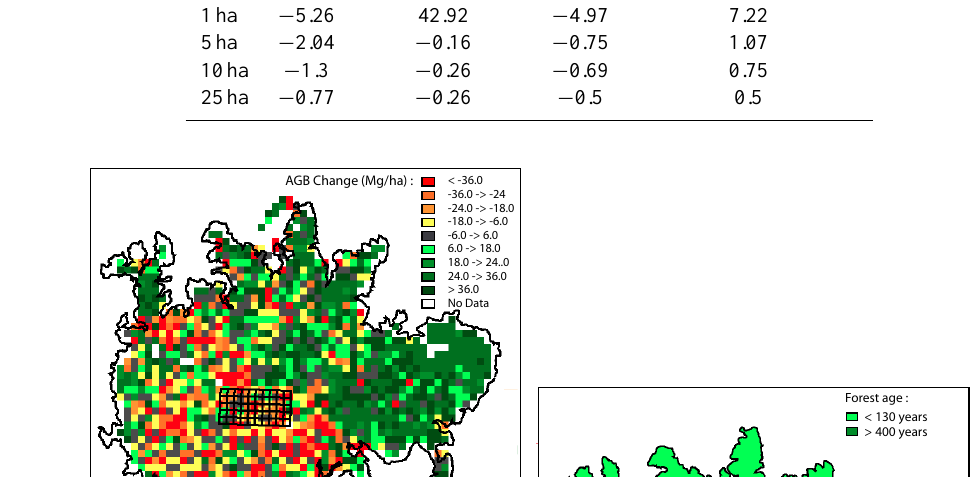
Table 5. lidar-detected AGB change (in Mgha − 1 yr − 1 ) and the difference between lidar and field AGB change estimates in the 50ha plot, at large plot scales. Both AGB change and the difference between lidar and field estimates decrease as the scale becomes coarser. lidar-detected AGB change Difference between lidar-detected (mean =− 0.77) AGB change and field estimations (mean = 0.02)